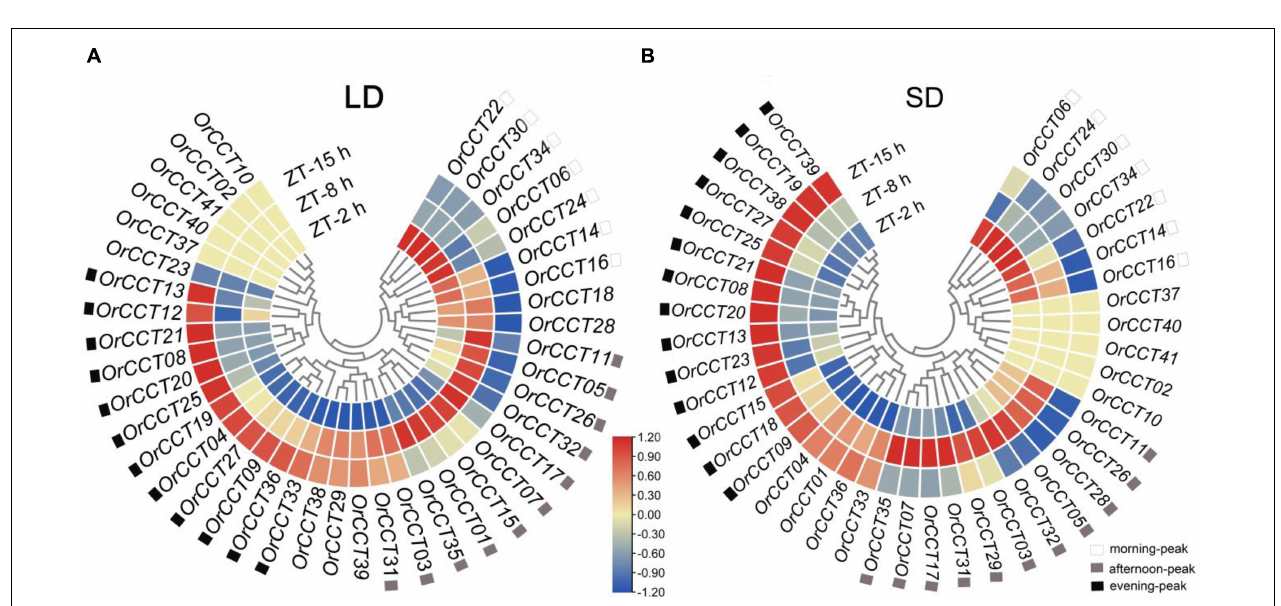
FIGURE 3 | Phylogenetic relationships of CCT TFs among B. distachyon , O. sativa ssp. japonica , O. sativa ssp. indica , O. nivara , and O. rufipogon . (A) The species tree following the number of CCT TFs among the investigated species; (B) Phylogenetic tree representing relationships among CCT TFs from the four plant species. The pink and green circles of the terminal node indicate COL gene with 1 and 2 BBOX, respectively. The prefixes of tree labels are Bd, B. distachyon ; Os, O. sativa ssp. japonica ; Ind, O. sativa ssp. indica ; On, O. nivara , and Or, O. rufipogon . The subfamilies are marked with red line: CMF ; blue: COL ; yellow: PRR . The locus of CCT TFs presenting here is listed in Supplementary Table 6